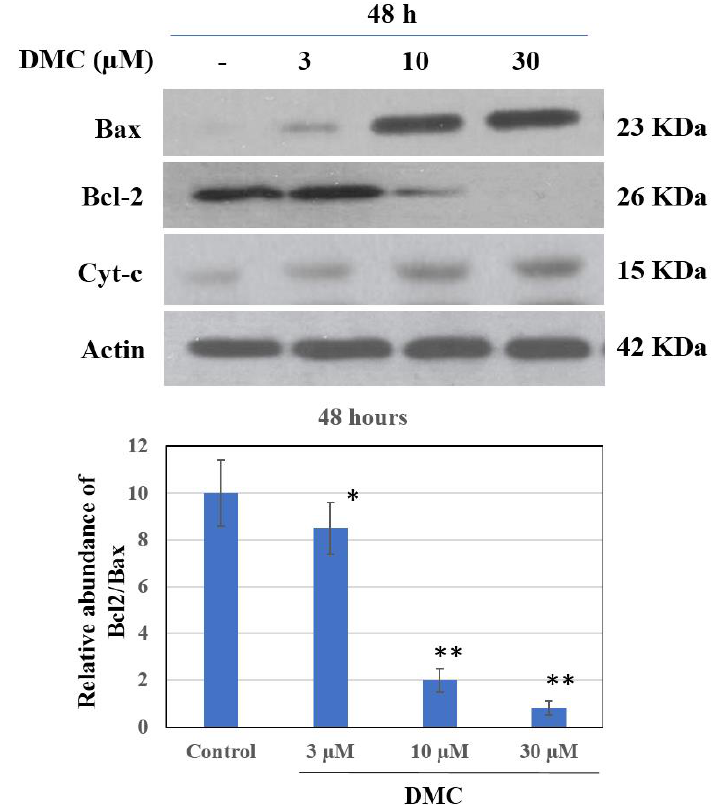
Figure 5. Effect of DMC on Bcl-2, Bax and Cyt-c protein expression in PANC-1 cells. Cells were treated with DMC (3–30 µ M) for 48 h. Protein 50 µ g / lane from cells lysates were electrophoresed on SDS-PAGE gels, then transferred to total blot PVDF membranes. β -Actin was used as a control, (–) 0.1% DMSO-treated cells. The experiments were carried out in three replicates. * P < 0.05 and P < 0.01 compared with control group.